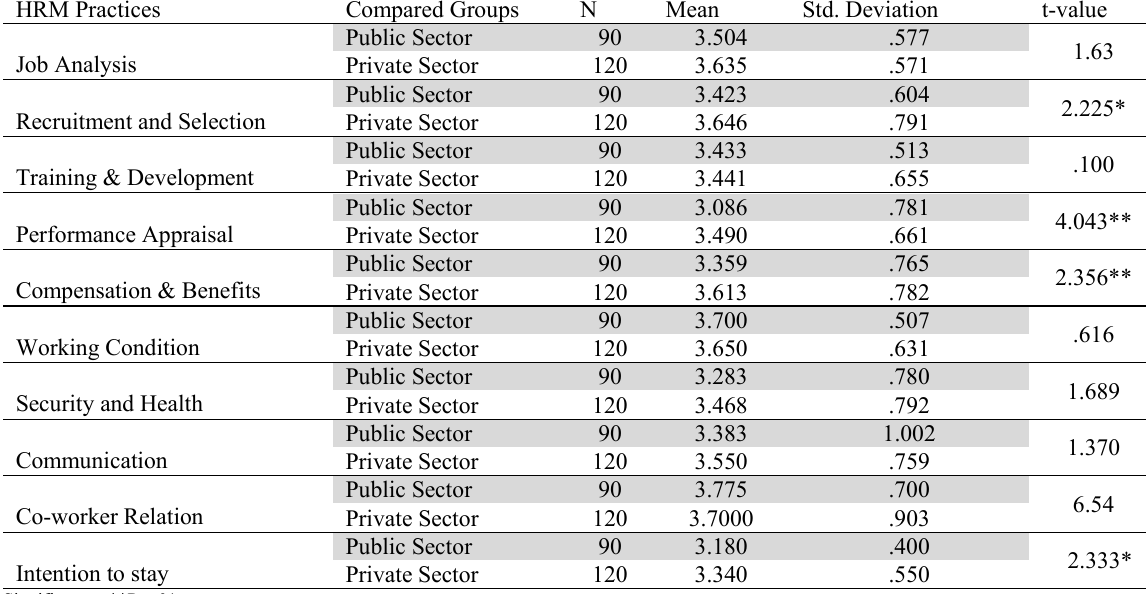
Mean, SD and t-value of public and private sector telecom employees on different HRM